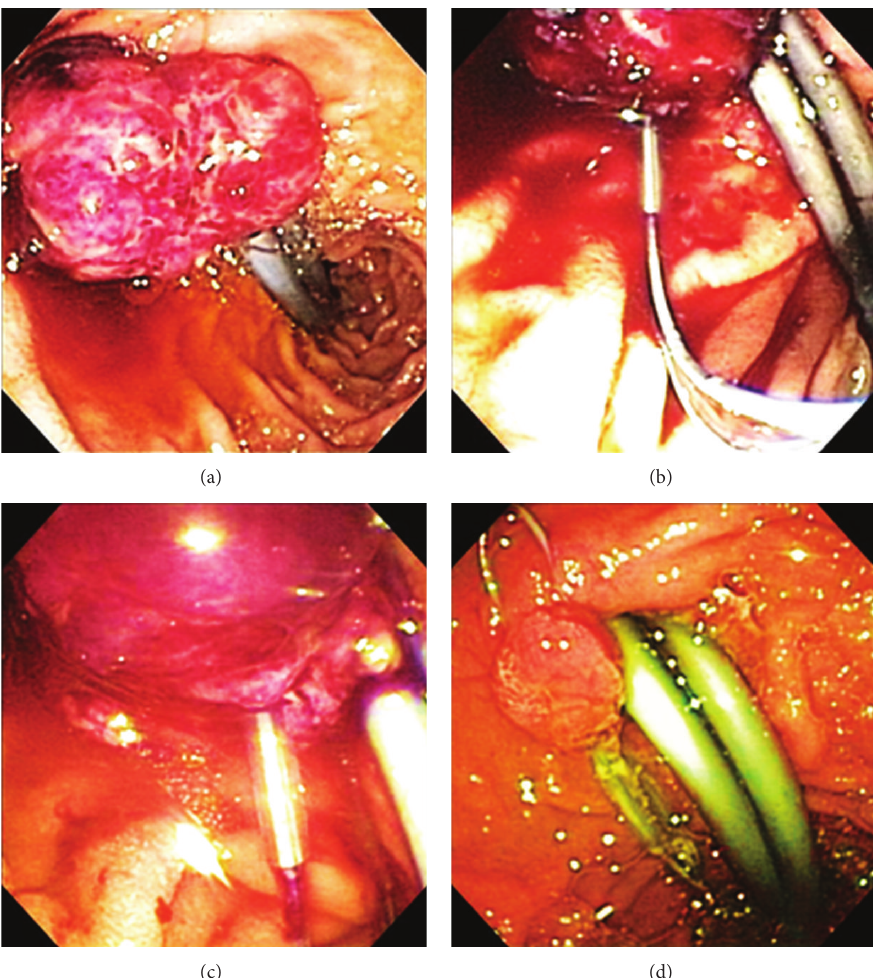
Figure 1: (a) A 3 × 2 cm ulcerated periampullary mass; previous biliary stents in place. ((b), (c)) First and second endoloops were deployed at the base of the mass one month apart. (d) Tumor remnant tissue one month after the second endoloop; two endoloops are still in